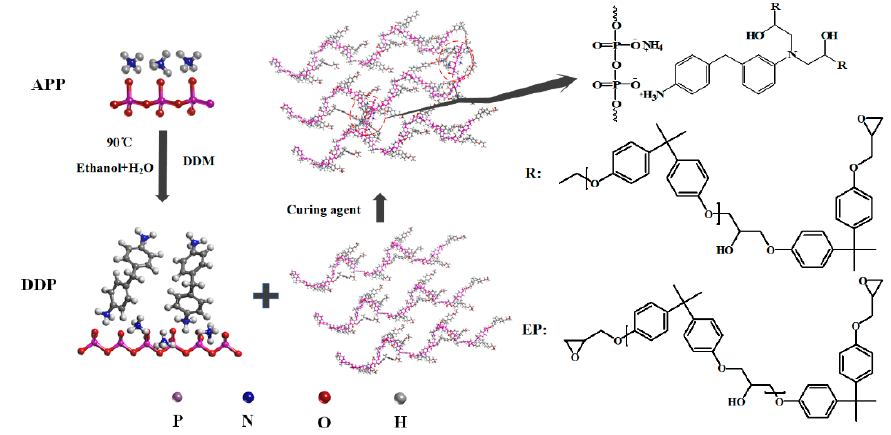
Figure 1. Preparation of DDP and its flame-retarded EP blends.